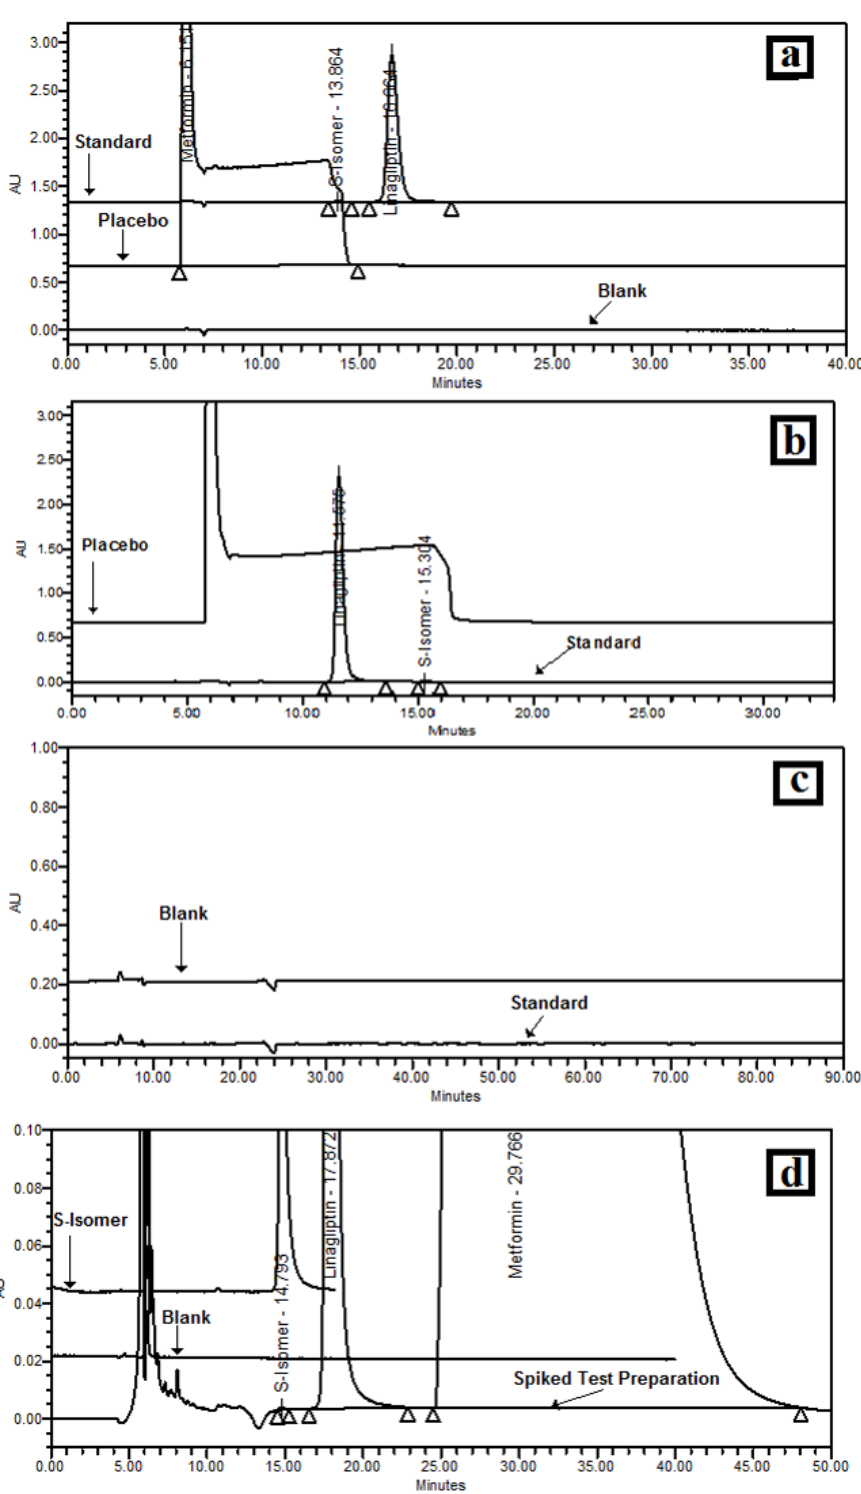
Figure 1. Optimisation of the column and mobile phase ( a ) chromatogram with EtOH:MeOH: monoethanolamine (MEA) (50:50:0.2) v / v / v using Chiralpak AD-H; ( b ) chromatogram with EtOH:isopropanol (50:50) v / v / v using Chiralpak OD-H; ( c ) chromatogram with EtOH: n -Hexane (10:90) v / v / v using Chiralpak OD-H; ( d ) chromatogram with EtOH:MeOH:MEA (60:40:0.2) v / v / v using Chiralpak